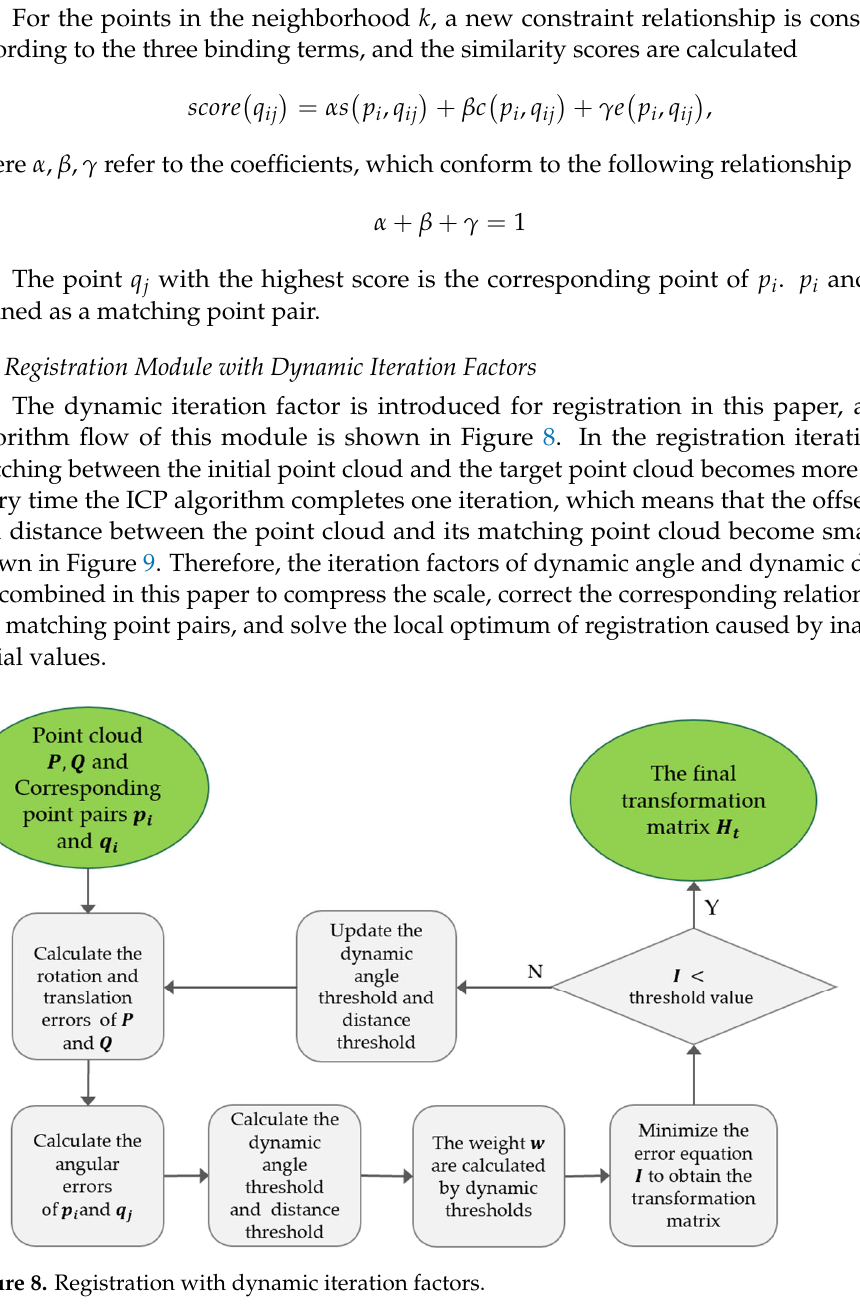
Figure 9. Point cloud iterative matching process: 𝑄 is iterated to position 𝑄 (cid:4593) with a smaller offset angle and distance from 𝑃 . We need to convert the matching point cloud 𝑄 into the coordinate system of 𝑃 , and calculate the coordinate transformation parameters 𝑅 (rotation matrix) and 𝑇 (transla ‐ tion vector). When 𝑄 and 𝑃 undergo continuous rotation and translation, the error func ‐ tions are minimized and the corresponding registration effect is optimal. The rotation translation error 𝐸(cid:3435)𝑝 (cid:3036) , 𝑞 (cid:3037) (cid:3439) is expressed as